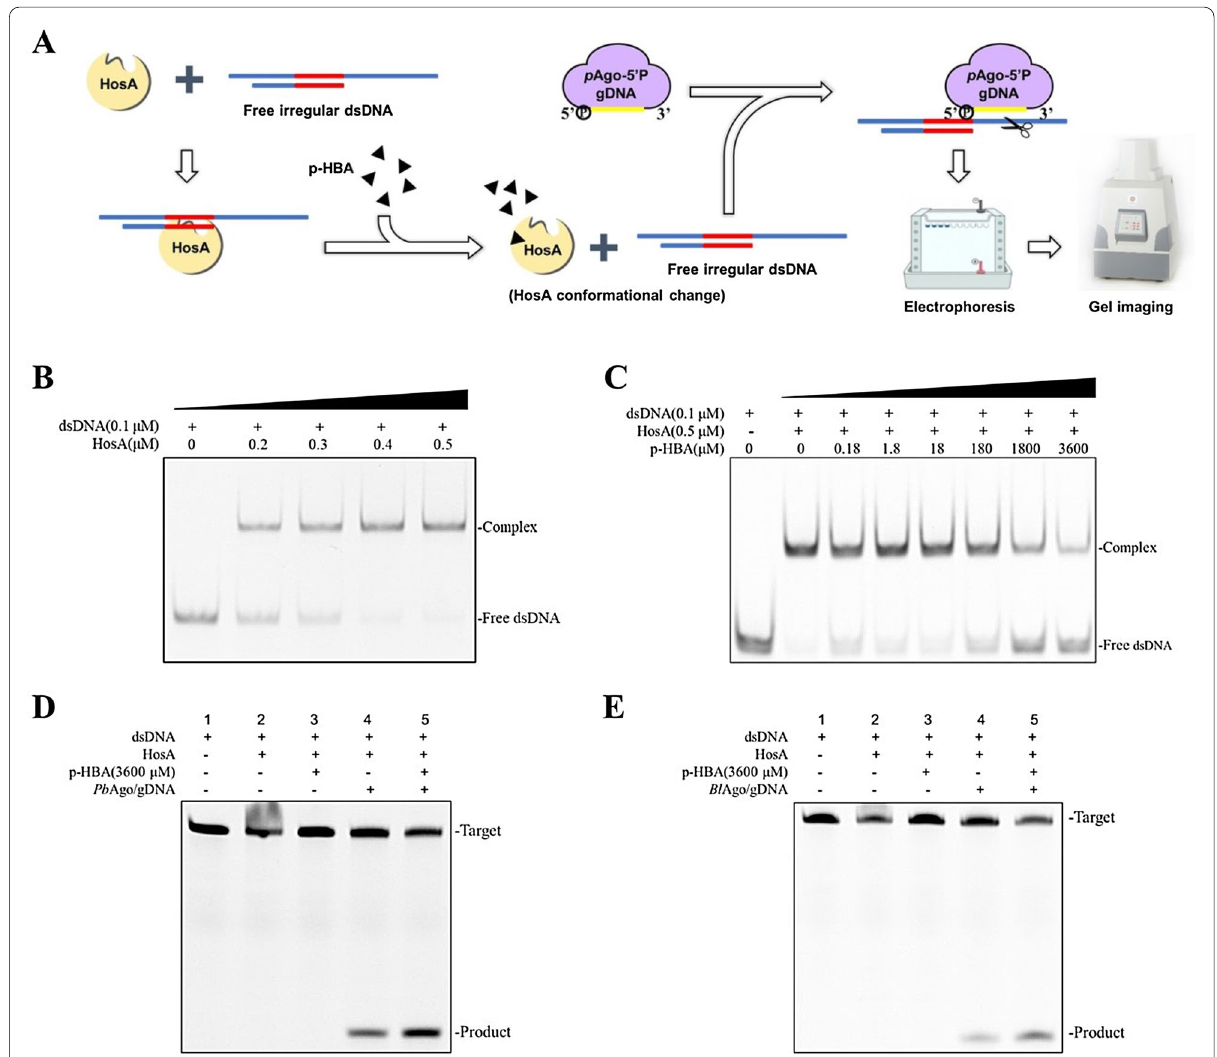
Fig. 5 Small molecule detection by Pb Ago and Bl Ago and allosteric transcription factors. a Schematic diagram of small molecule detection by Pb Ago and Bl Ago and allosteric transcription factors. b EMSA with HosA and irregular dsDNA containing the HosA-binding motif. c EMSA evaluation of HosA allosteric activity in the presence of p-HBA. d The denaturing polyacrylamide gel electrophoresis (PAGE) result of Pb Ago detecting p-HBA. The denaturing PAGE with irregular dsDNA (lane 1), with irregular dsDNA incubated with HosA (lane 2), with irregular dsDNA incubated with HosA and p-HBA (lane 3), with irregular dsDNA incubated with HosA and Pb Ago/gDNA (lane 4), and with irregular dsDNA incubated with HosA, p-HBA, and Pb Ago/gDNA (lane 5). e The denaturing PAGE result of Bl Ago detected p-HBA. The denaturing PAGE with irregular dsDNA (lane 1), with irregular dsDNA incubated with HosA (lane 2), with irregular dsDNA incubated with HosA and p-HBA (lane 3), with irregular dsDNA incubated with HosA and Bl Ago/gDNA (lane 4), and with irregular dsDNA incubated with HosA, p-HBA, and Bl Ago/gDNA (lane